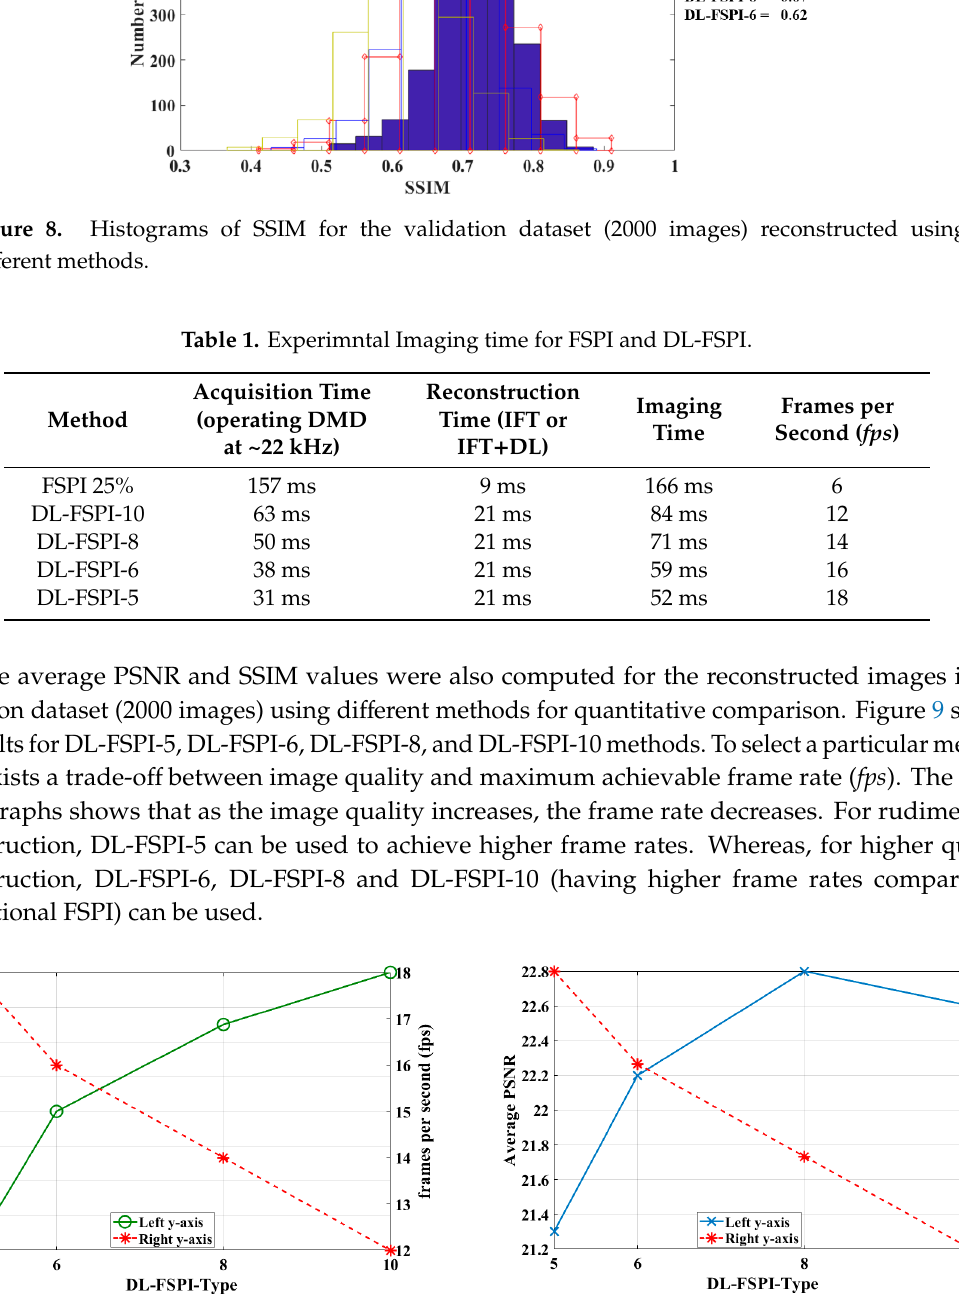
Figure 10. DL-FSPI experimental setup. The practical application of the proposed model was verified on diverse scenes (unseen during training) through two types of experiments. (1) Experiment 1: In the first experiment, the under-sampled images were acquired (through FSPI) from the imaging setup, and then the network was trained on those images for reconstruction. (2) Experiment 2: In the second experiment, the DL-FSPI model (DCAN block in Figure 10) trained on STL-10 dataset was applied directly onto the data from the imaging setup (under-sampled FSPI based images). The results from the first experiment are shown in Figure 11. In this experiment, the images were taken from random datasets (Peppers, Lena, Dog etc.). The under-sampled FSPI reconstructions (5%, 6%, 8%, and 10%) were first acquired from the imaging setup and these were set aside as input images for training. The output label for training the network was set to be ground truth for the